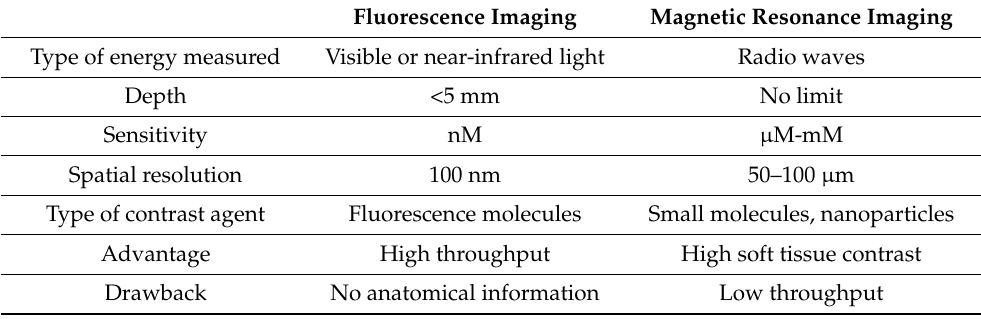
Table 3. A comparison of fluorescence and magnetic resonance imaging techniques. Fluorescence Imaging Magnetic Resonance